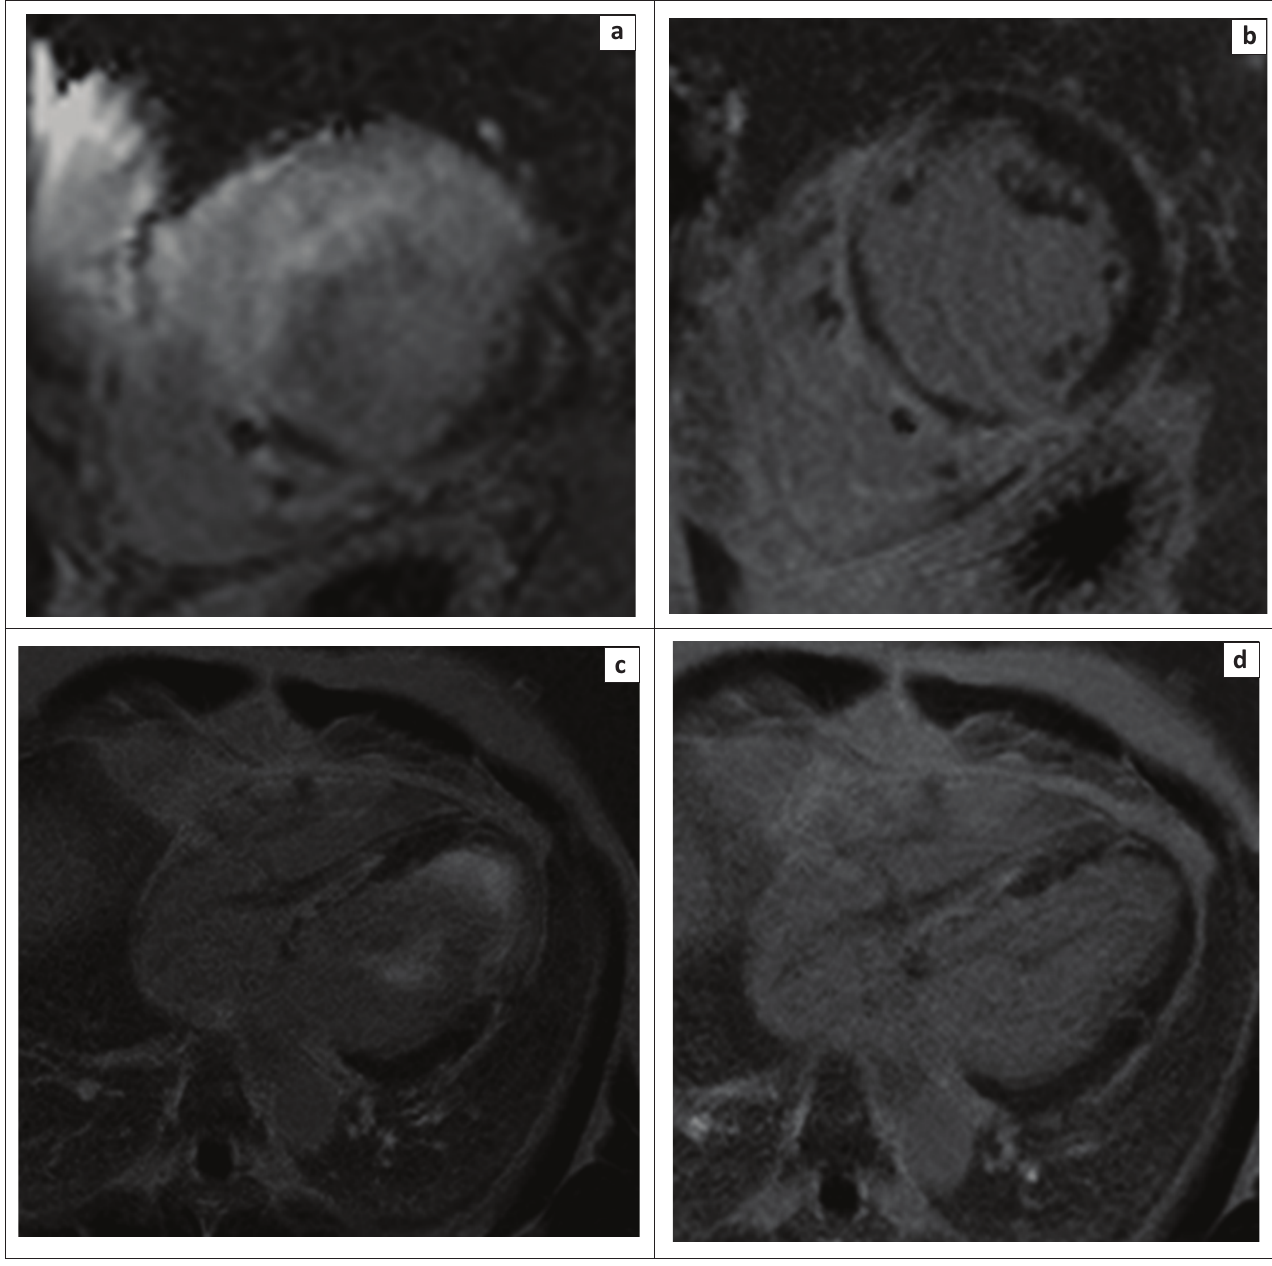
FIGURE 5: LGE acquisitions in a 52-year-old patient with cardiac sarcoid and an ICD. There is significant high signal intensity artifact overlying the heart from the ICD generator on the short-axis: (a) and 4-chamber view; (c) typical LGE sequence, which mimics transmural LGE. High signal intensity artifact is eliminated using the modified wideband LGE technique on short-axis; (b) and 4-chamber views; (d) LGE sequence and demonstrate true areas of LGE in the